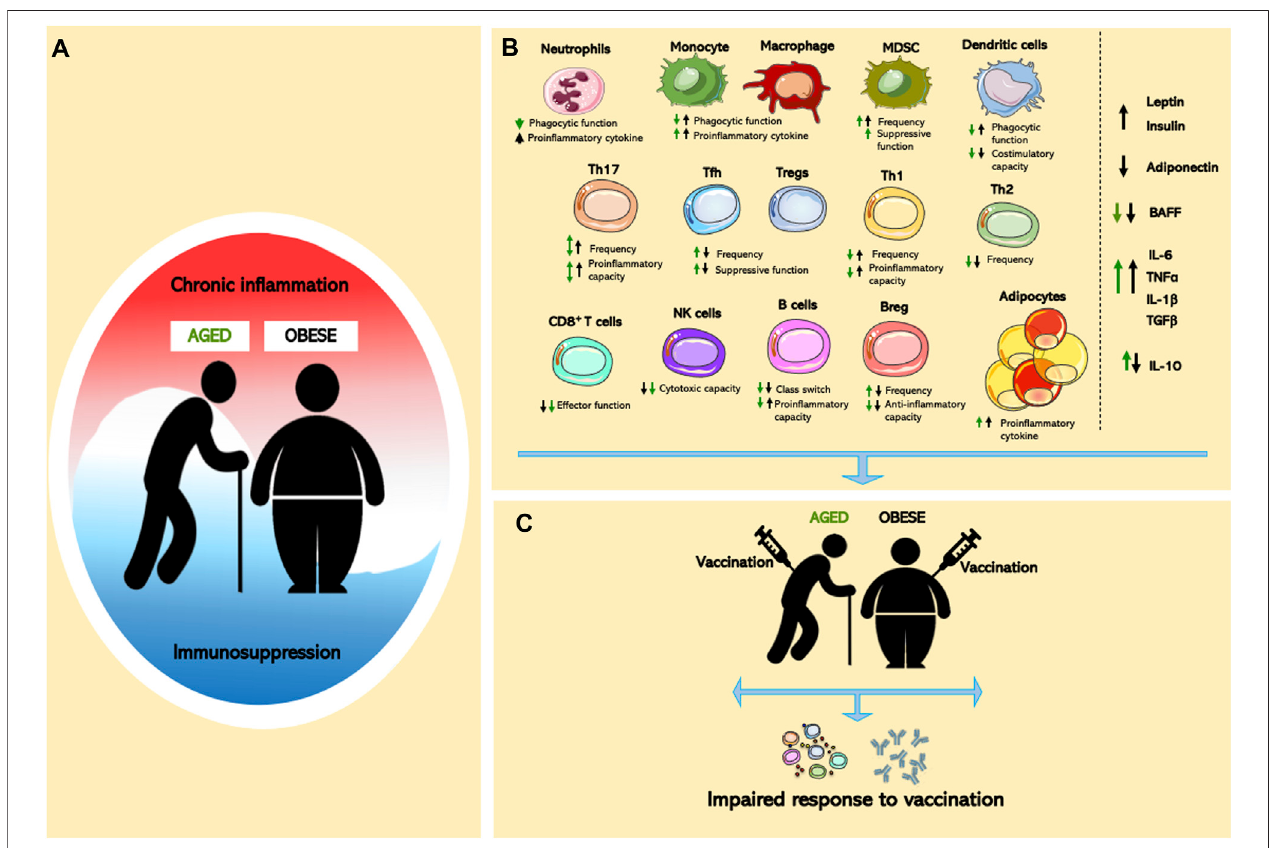
FIGURE 1 | Effects of aging and obesity on immune system. (A) Chronic in fl ammation and immunosuppression are a dynamic process in aging and obesity. (B) Cellular dysregulated adipocytes, innate/adaptive immune cells, and pro- and anti-in fl ammatory mediators in aged or obese individuals lead to global immune cell dysfunction. (C) Immunological dysfunction contributes to impaired vaccine responses in age and